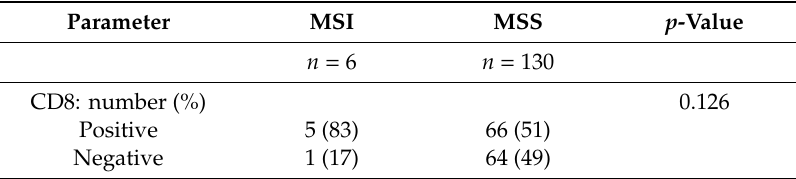
Table 2. Relationship between MSI status and CD8